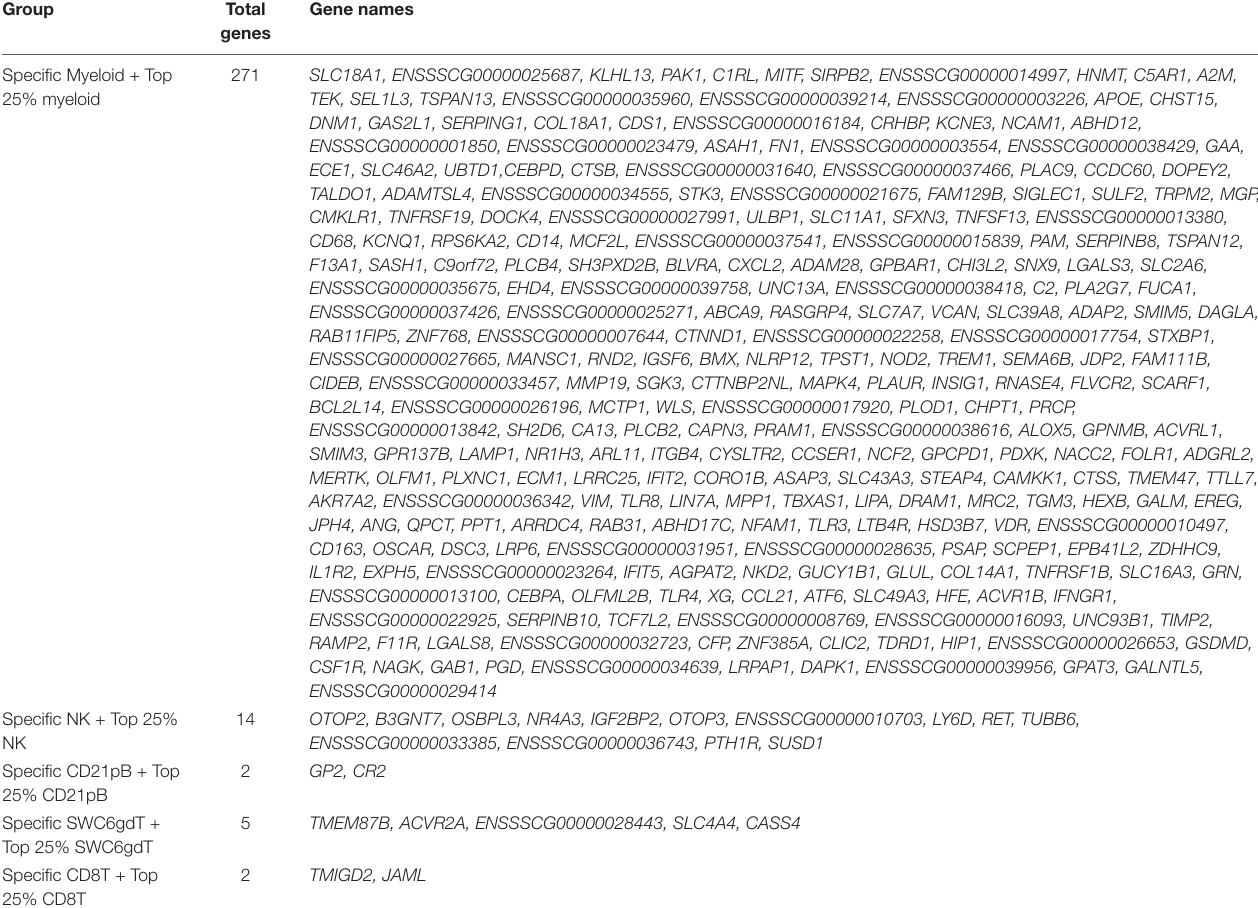
TABLE 3 | Specific highly enriched genes in myeloid, NK, CD21pB, SWC6gdT, and CD4CD8T-cells. Group Total